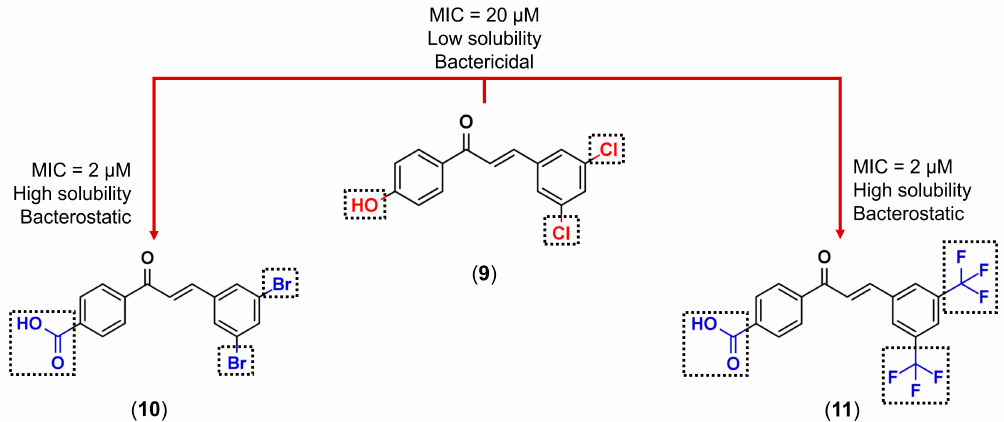
Figure 4. Bioisosterism represented by the replacing the hydroxyl and chloride groups (red) with a carboxylic acid and hydrophobic groups (blue) [46].